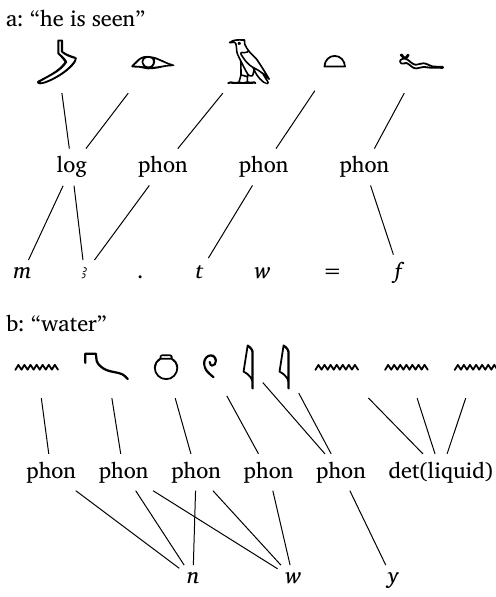
Figure 3: Further annotations (Shipwrecked